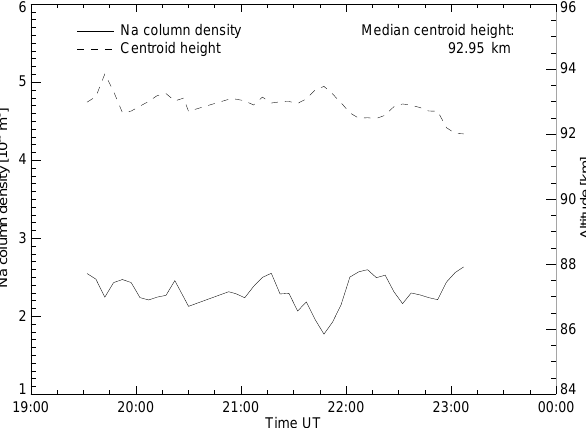
Fig. 4. As Fig. 3, but 13 December 2010. The vertical line indicates the launch of ECOMA